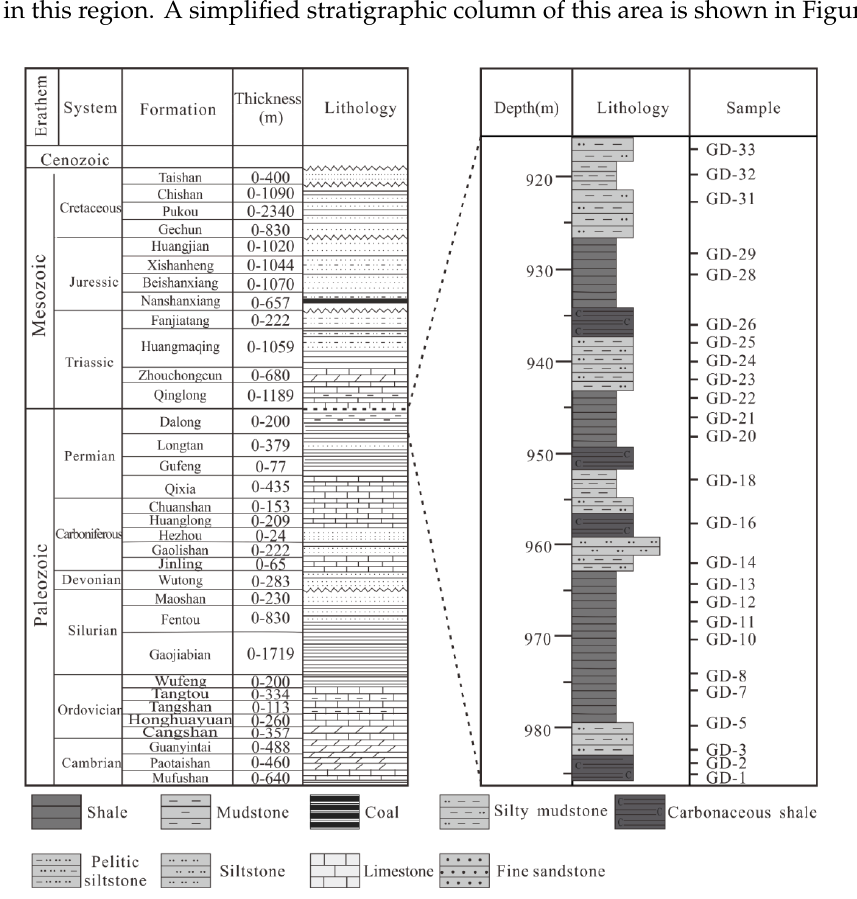
Figure 2. The study area stratigraphic column and its corresponding depositional environment, with sampling location of the Dalong Formation. sampling location of the Dalong